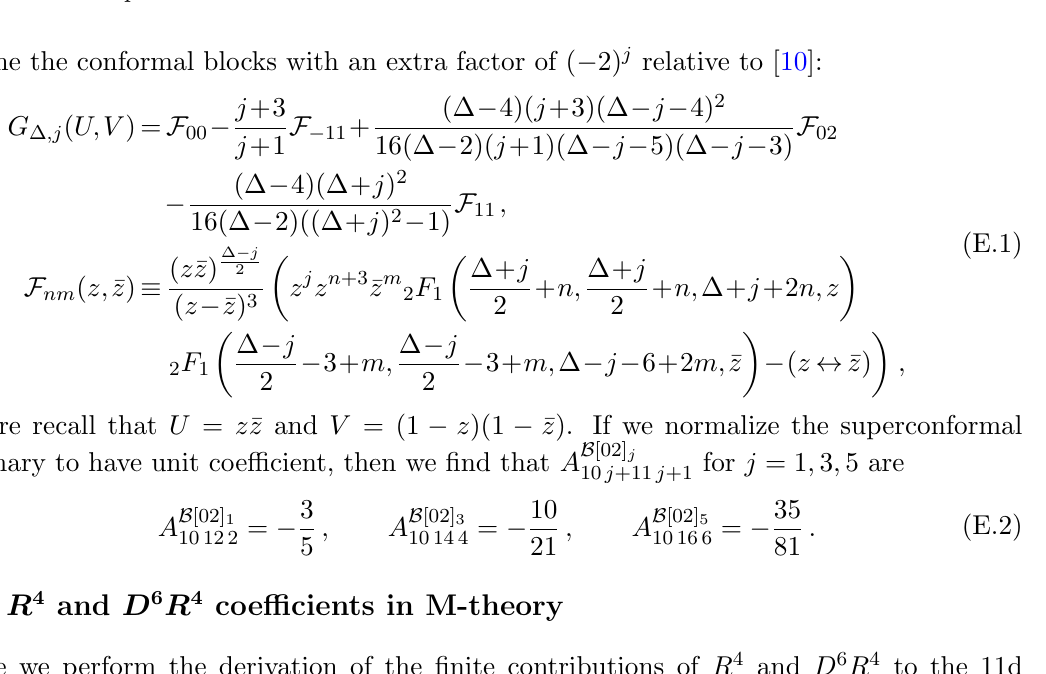
Table 8 . All possible conformal primaries in D [20] (cid:2) D [20] corresponding to the A [00] conformal